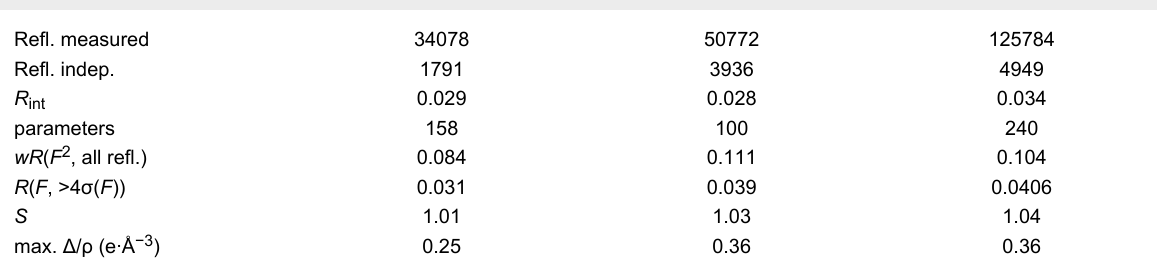
Table 2: Crystallographic data for compounds 1 , 2 ·CH 3 OH, 3 ·C 2 H 5 OH. (continued) Refl.